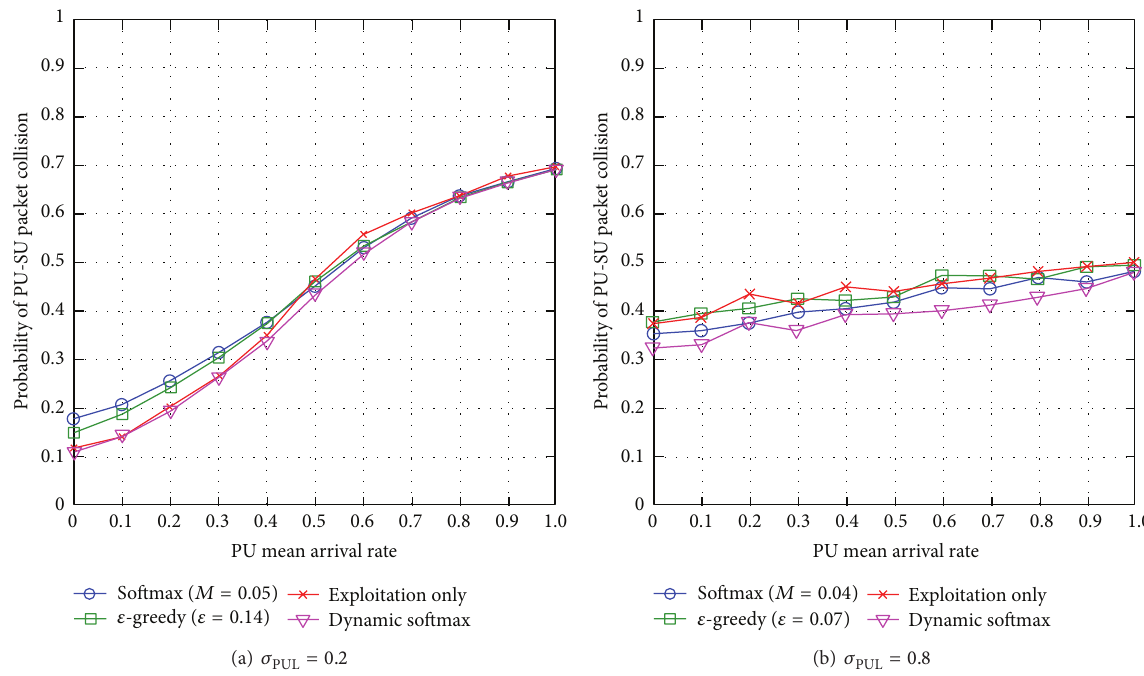
Figure 11: SUs’ interference to PUs for varying PU mean arrival rate 𝜇